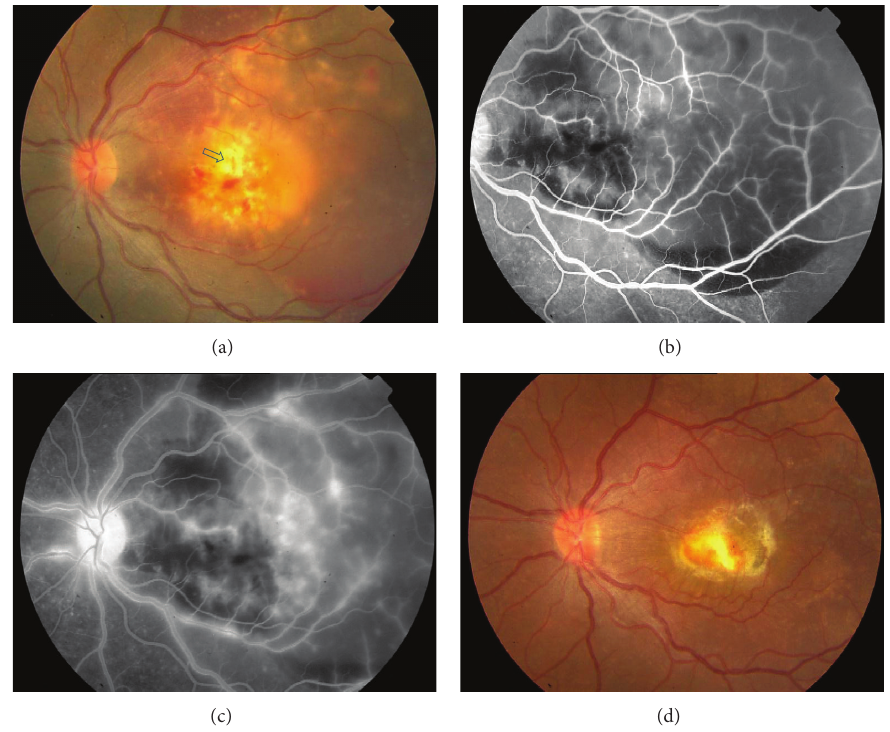
Figure 1: (a) Color fundus photograph showing yellow-white submacular granuloma. Also observed are satellite lesions, retinal hemorrhage, perivascularsheathing,andserosanguineousdetachmentofneurosensoryretinaextendingbeyondtemporalvasculararcades.Thearrowhead indicates the site of observed motile parasite. (b) Fluorescein angiography (early phase) demonstrates patchy blocked fluorescence by subretinal blood. (c) Late phase of fluorescein angiogram shows disc and retinal vascular leakage at and around posterior pole. (d) Color photograph documents resolution of the granuloma with resultant pigmented macular scar. The status remained stable till 4 years following treatment with albendazole and oral corticosteroids.